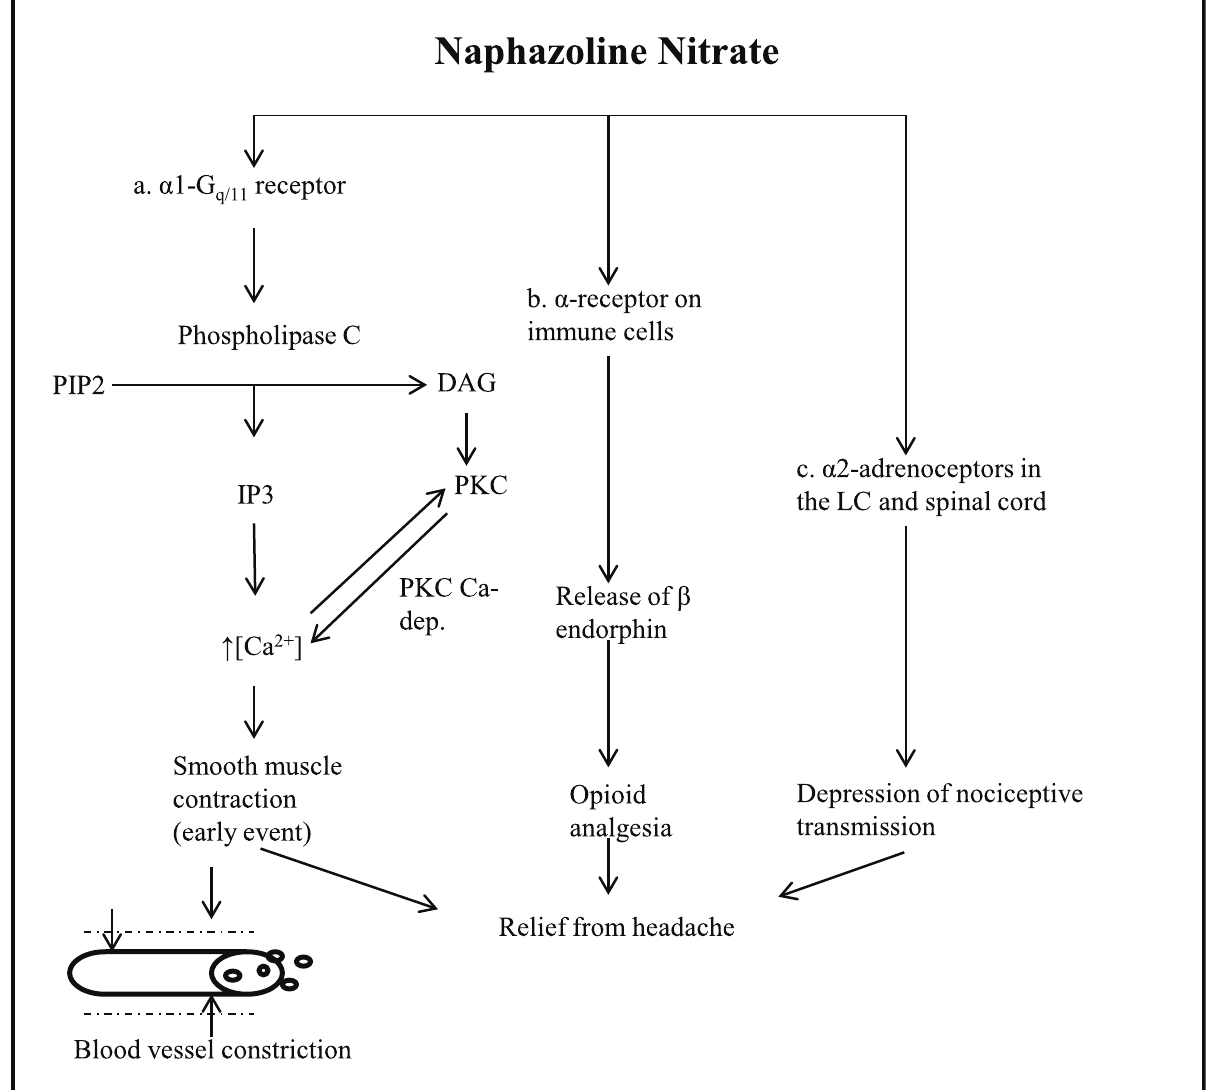
Figure 2. Possible early events that induce peripheral analgesic effect. a . Naphazoline activates alpha1 receptors that are associated with G-proteins that cause the activation of phospholipase C. Phospholipase C cleaves phosphatidyl-inositol 4,5-bisphosphate (PIP2) into inositol 1,4,5-trisphosphate (IP3). Consequently there is a smooth muscle contraction due to an increase of intracellular calcium. b . Alpha-Receptors on immune cells release β -endorphins that cause opioid analgesia. c . Activation of alpha2 adrenoceptors in the Locus Coeruleus and spinal cord provokes the depression of nociceptive transmission 12